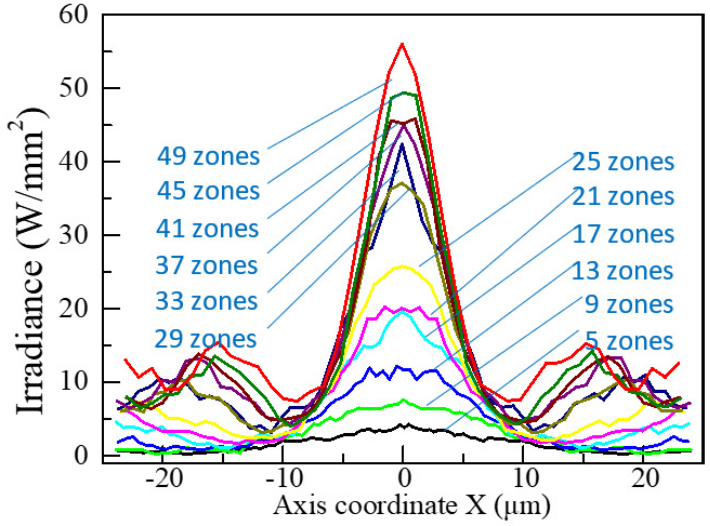
Figure 7. Contrast image of focal point morphology of S − FZPs with different numbers of zones.